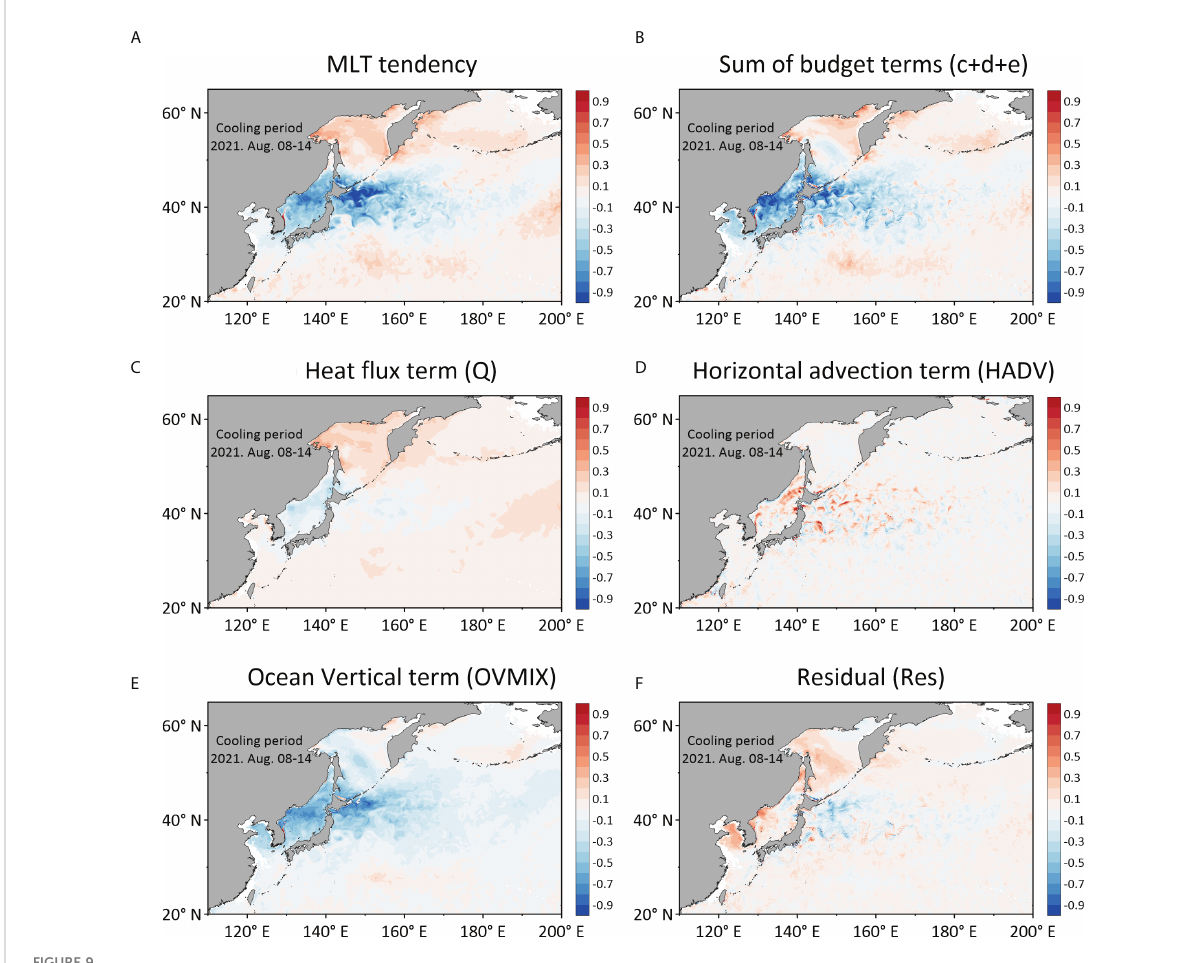
FIGURE 9 Spatial maps depicting the distribution of mixed-layer temperature (MLT) tendency budgets during the cooling period: (A) MLT tendency, (B) sum of budget terms, (C) surface heat fl ux term (Q), (D) horizontal advection term (HADV), (E) ocean vertical mixing term (OVMIX), and (F) residuals (Res).